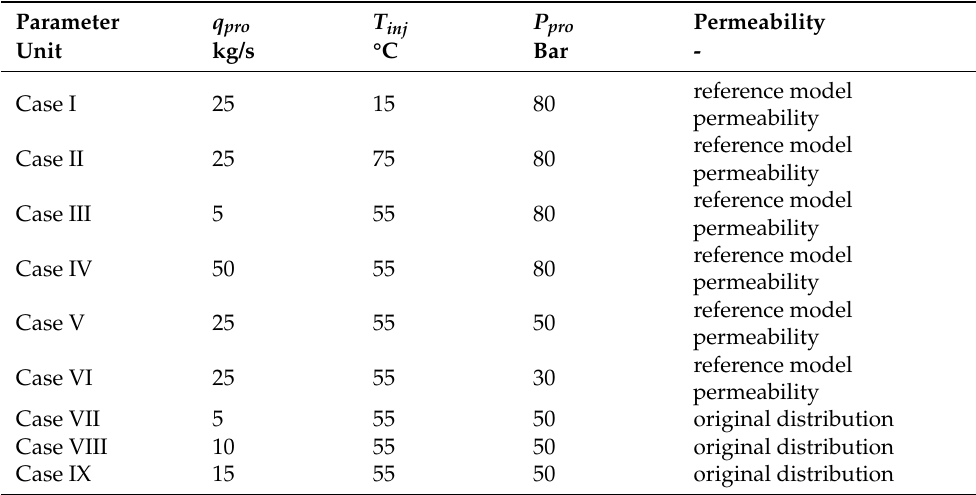
Table 5. Summary of the simulation properties for each of the investigated cases